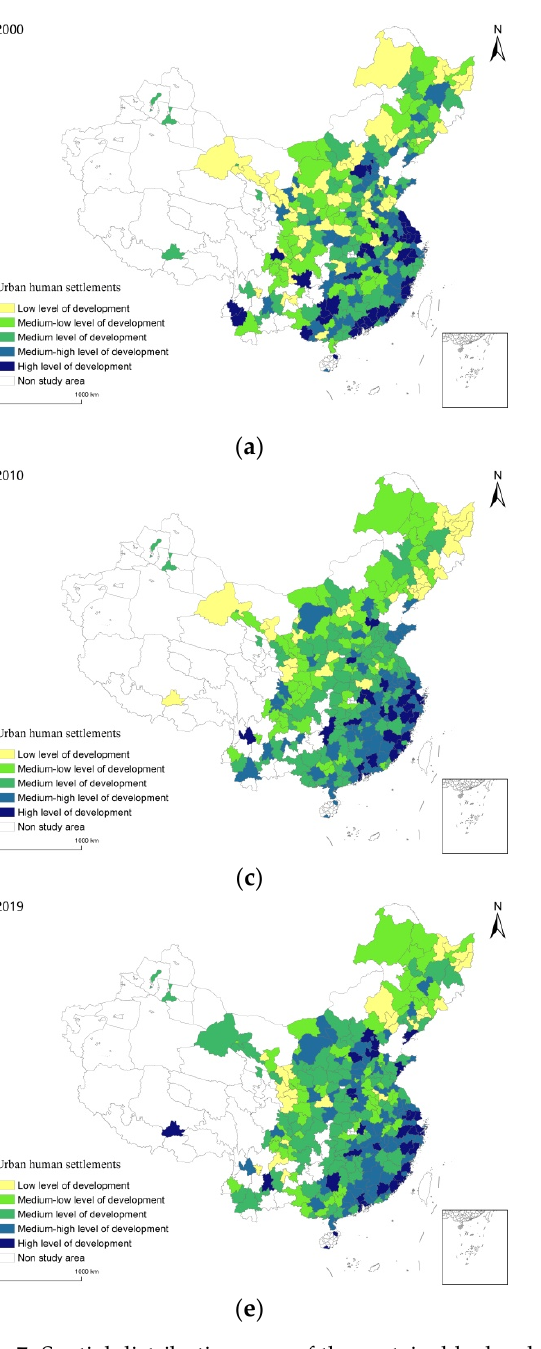
Figure 7. Spatial distribution map of the sustainable development level of urban human settlements in China. ( a ) 2000; ( b ) 2005; ( c ) 2010; ( d ) 2015; and ( e ) 2019. Table 2. The top ten cities in China’s urban human settlements development level and their scores.